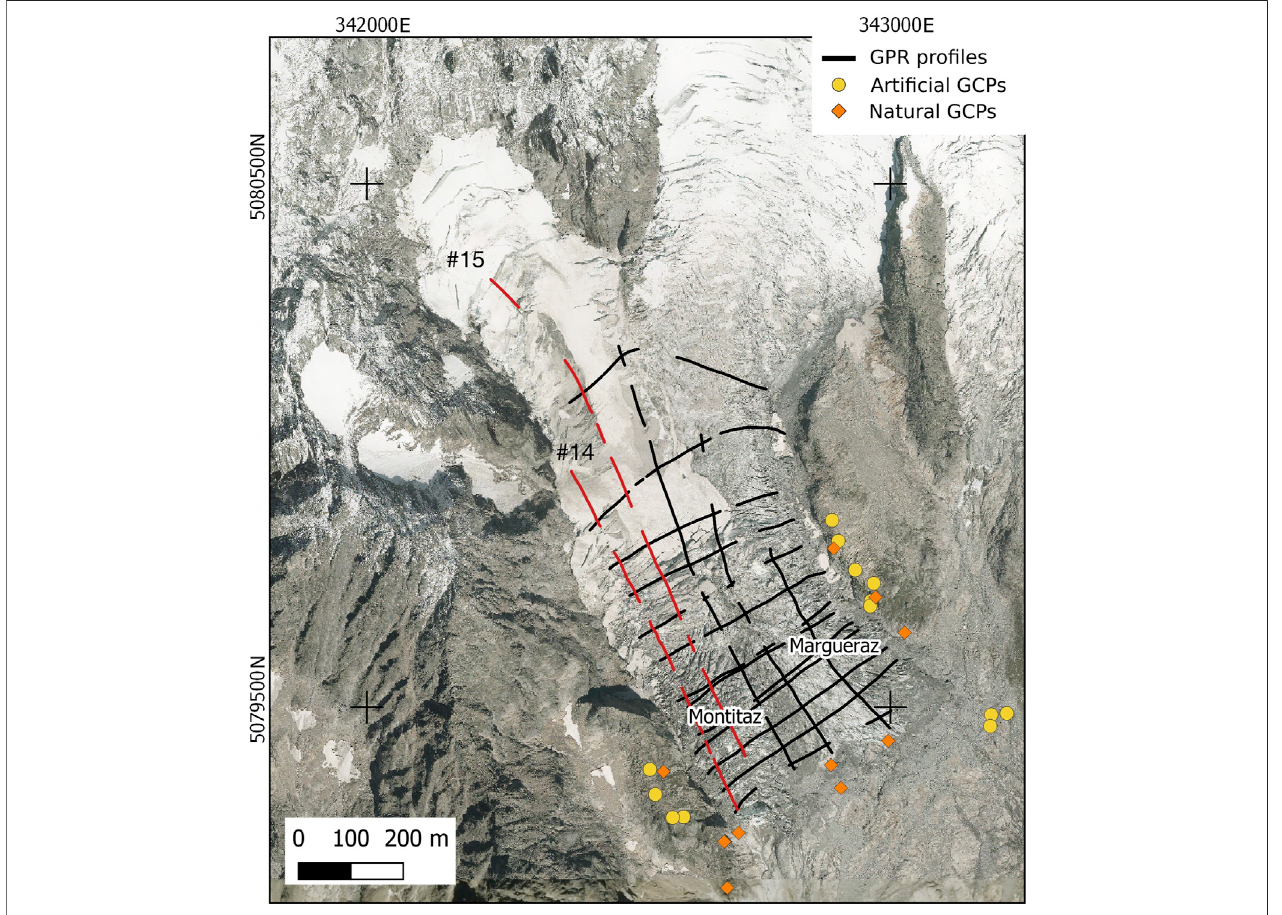
FIGURE 2 | GPR pro fi les acquired on 7 July 2020 at the Planpincieux glacier (black lines). The two westernmost longitudinal pro fi les (in red in the colored version) are n. 14 and 15. The colored dots indicate the ground control points (GCPs).